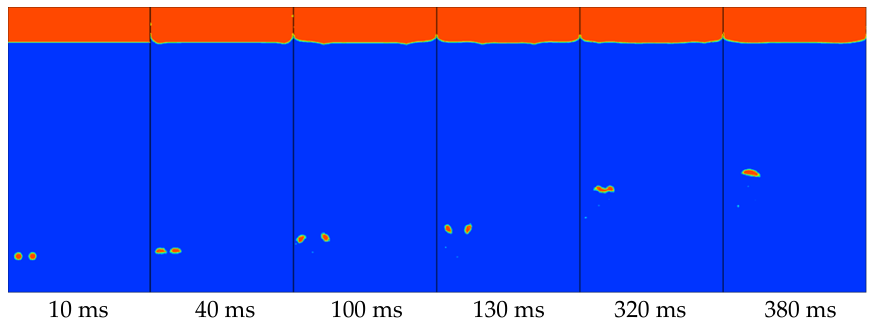
Figure 16. The shape change of the rising double bubbles arranged vertically near the wall. Figure 17 shows the surrounding flow field distribution of two bubbles at 50 ms. At this time, the bubbles are beginning to move away from each other. When there is a single bubble near the wall, due to the influence of the left wall, the flow field on the left side of the fluid will flow closer to the left side of the bubble. The direction of the flow velocity is more the tangent direction of the left side of the bubble, and the flow velocity on the left will be faster than that of unbounded still water. As a result, the flow field at the bottom of the bubble forms a situation where the left side is less and the right side is more. In the case of double bubbles, it can be seen from the figure that two jets merge between the two bubbles, causing the two bubbles to have a fast flow velocity in the middle of the bubble and a slow flow velocity on both sides, thus forming a deflection of the two bubbles away from each other. The flow field on the left side of the left bubble is affected by the wall, and the flow field on the right side of the right bubble has no boundary. The bubble on the left will swing wider than the bubble on the right, and the overall path of the two bubbles will gradually deviate from the wall.